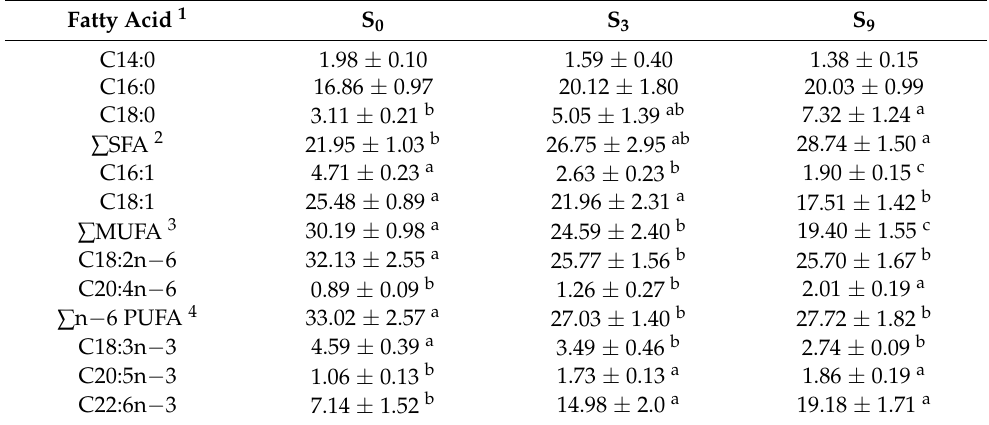
Table 2. Effects of salinity on fatty acid contents of muscle in M. salmoides (%, means ± S.D., n = 3).